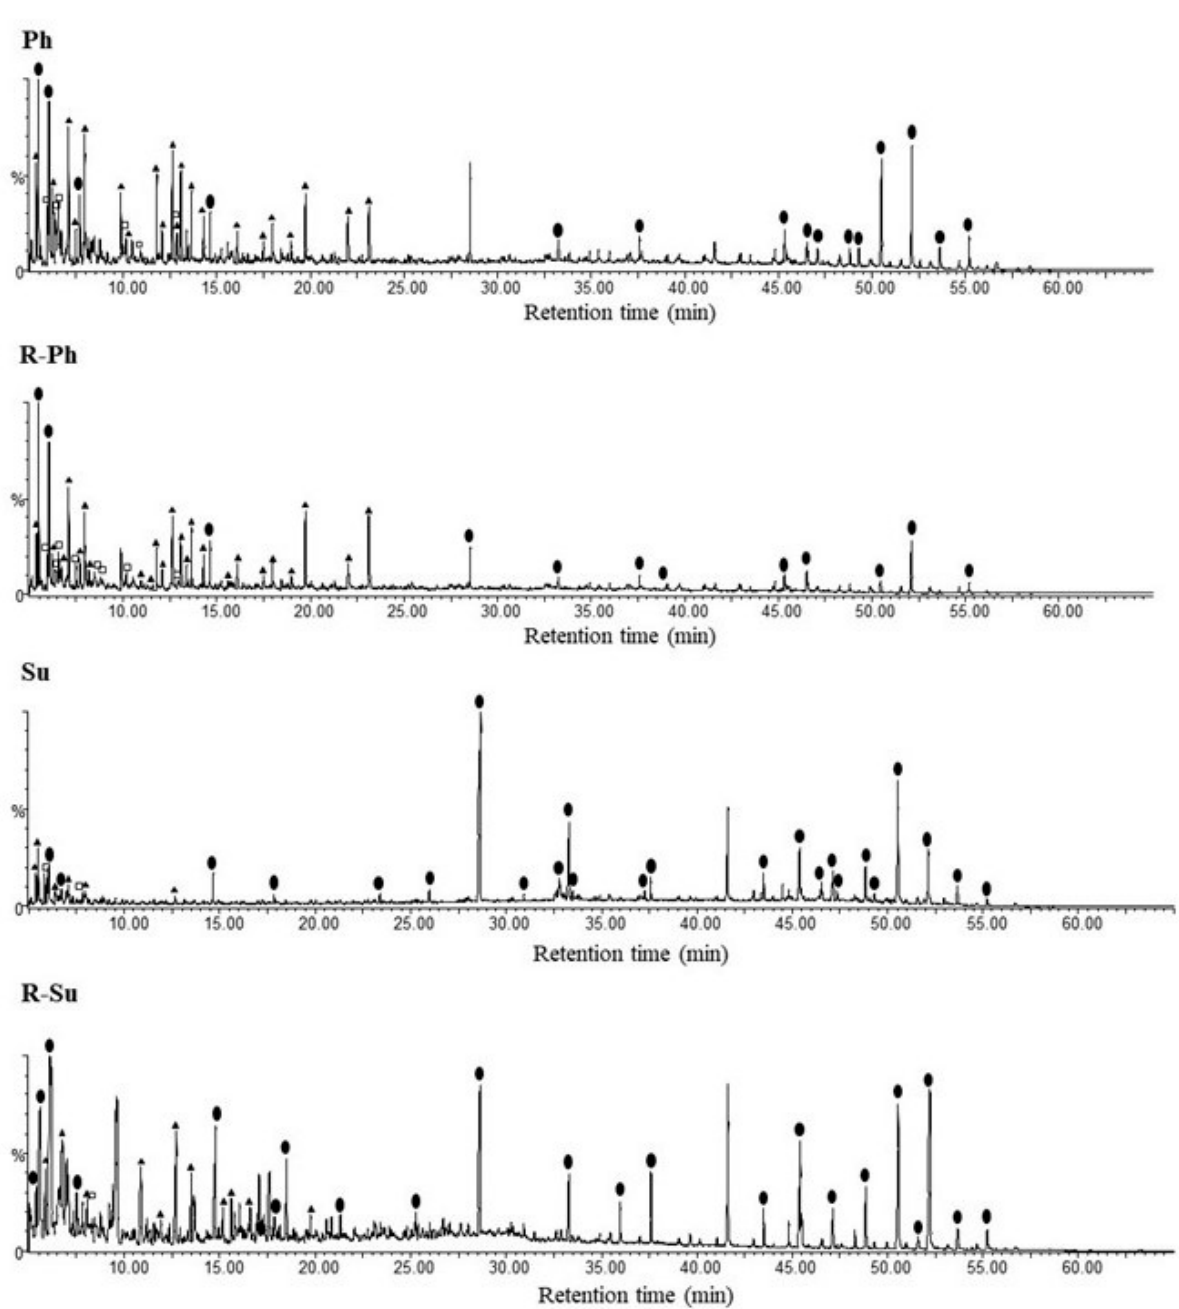
Figure 3. Chromatograms of thermochemolysis products of the four hydrochars (Ph, R-Ph, Su, and R-Su). ( □ ) phenolic compounds; ( ▲ ) benzene derivative; ( ● ) aliphatic esters.